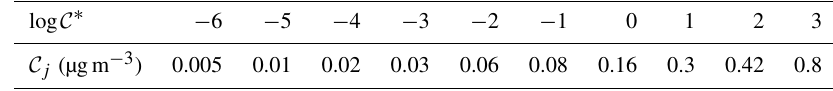
Table 4. Volatility distribution of SVOCs from Cappa and Jimenez (2010).